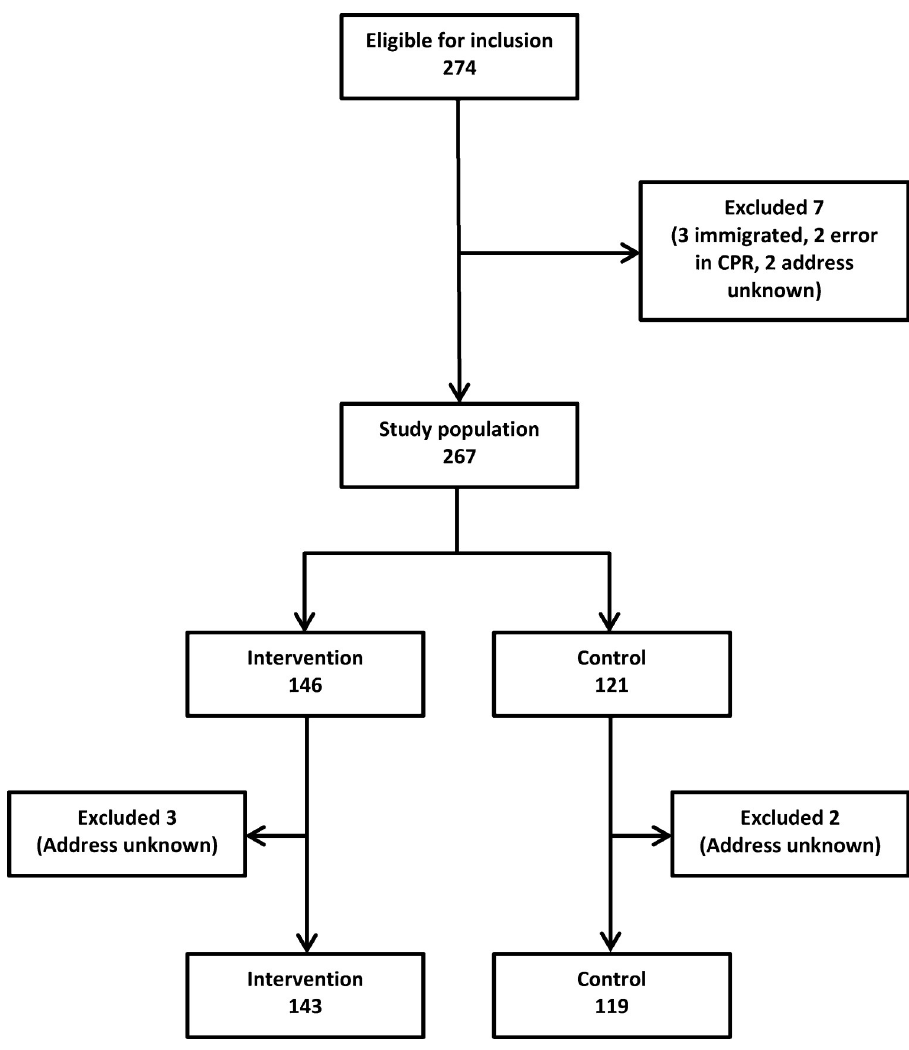
Fig 1. Flow diagram for participants included in the